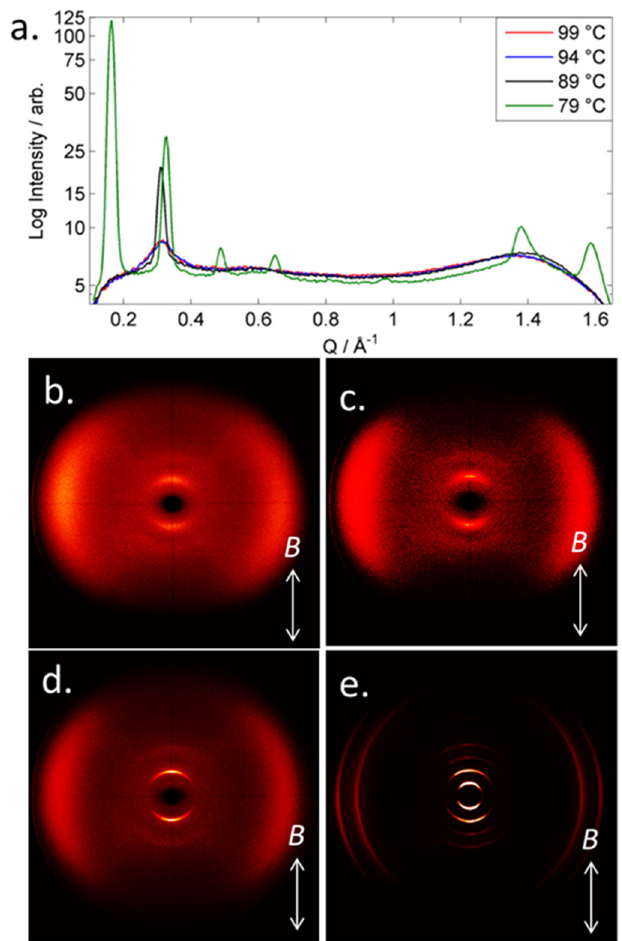
Figure 3. SAXS/WAXS studies on compound CB8OFFFT : ( a ) plot of intensity (log, arb.) as a function of Q (Å − 1 ) at 99 °C (nematic, red), 94 °C (N TB , blue), 89 °C (SmC A , black) and 79 °C (X, green). Magnetically aligned 2D SAXS patterns in ( b ) the nematic phase at 105 °C, ( c ) the N TB phase at 94 °C, ( d ) the SmC A phase at 85 °C and ( e ) the ‘’X’’ phase at 74 °C.